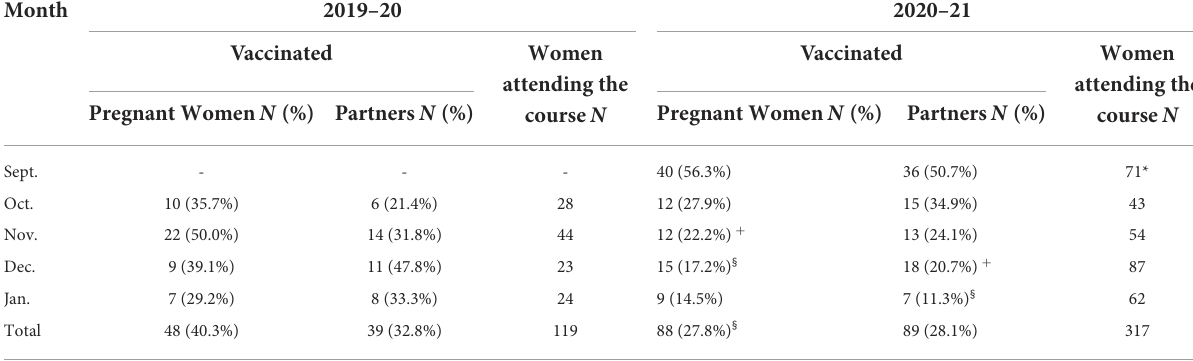
TABLE 5 Number and percentages of vaccinated subjects by month before and during the COVID-19 pandemic in the flu seasons 2019–20 and 2020–21.